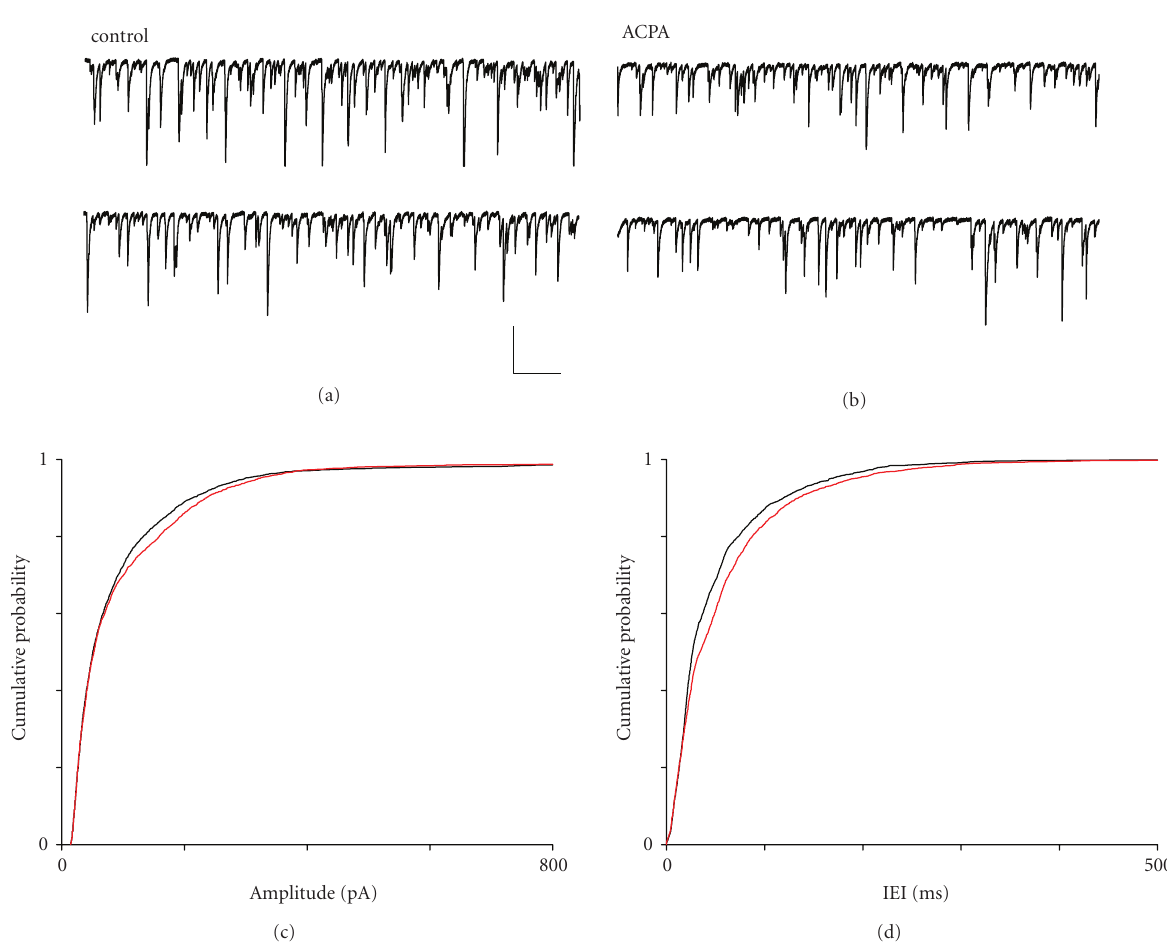
Figure 6: The e ff ects of ACPA on sIPSCs in mEC layer II. (a) Recording from a layer II neurone under control conditions and (b) in the presence of ACPA (10 μ M). (c) Cumulative probability plot for sIPSC amplitude under control (black) and ACPA (red) conditions. (d) Cumulative probability plot for sIPSC IEI under control (black) and ACPA (red) conditions. Scale bars 500 millisconds ×